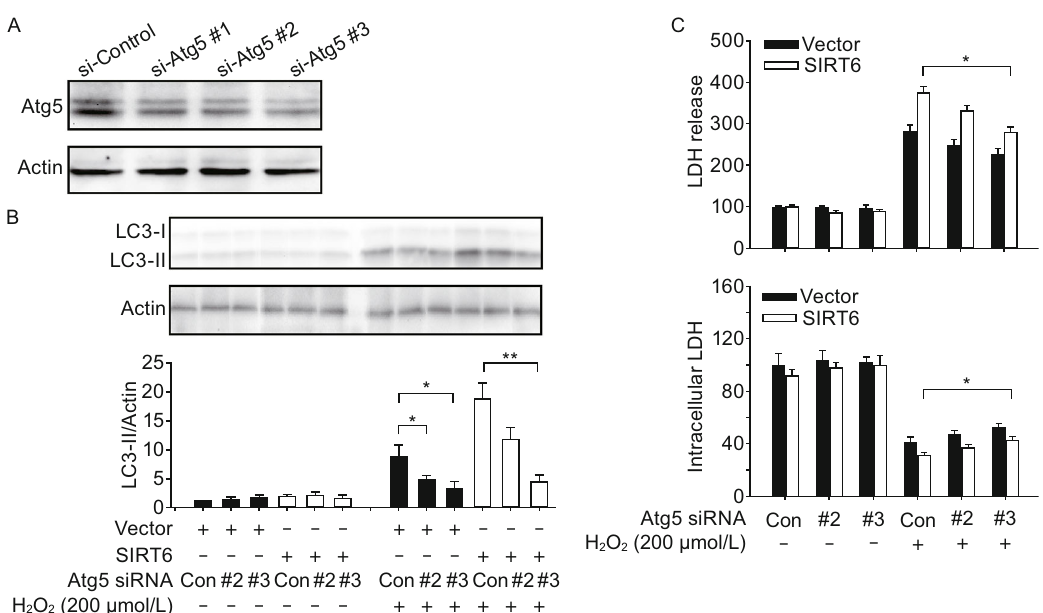
Figure 4. SIRT6-regulated autophagy is responsible for H 2 O 2 -induced neuronal cell death. (A) Knockdown of Atg5 by siRNAs. (B) SH-SY5Y cells were exposed to H 2 O 2 for 1 h and then cultured for 24 h after transfection with Atg5 siRNAs. LC3 levels were analyzed by Western blot and quanti fi ed. (C) SH-SY5Y cells were exposed to H 2 O 2 for 1 h and then cultured for 24 h after transfection with Atg5 siRNAs. Cell death and viability were assessed by LDH assay. Bars represent the mean ± SEM from at least three independent experiments. * P < 0.05; ** P